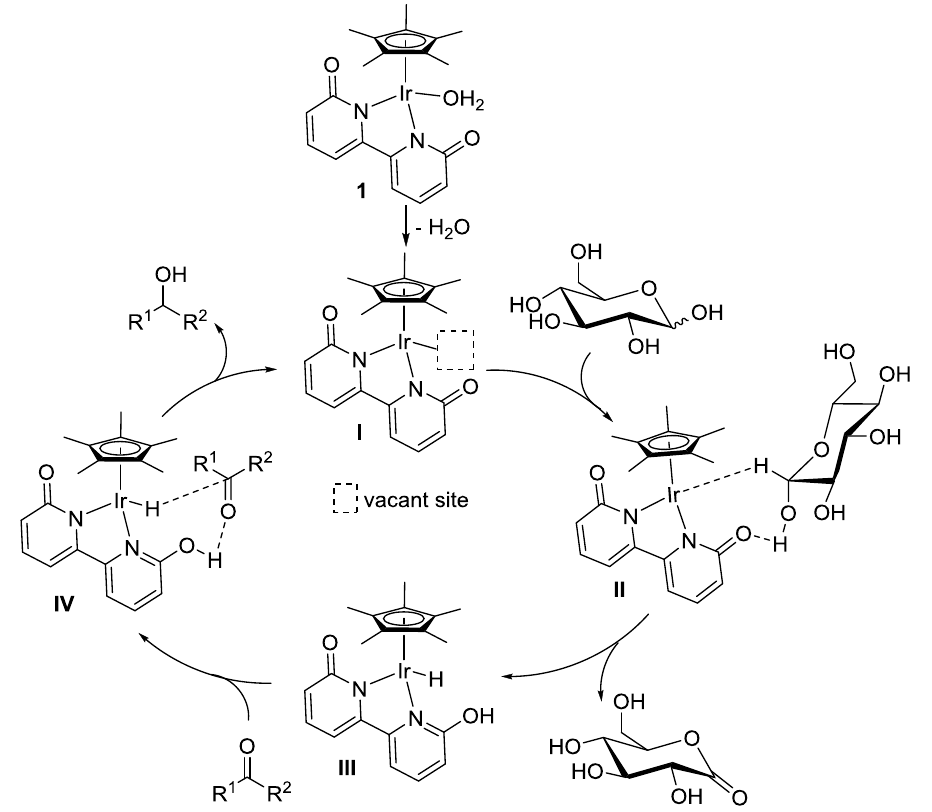
Figure 1. Additional experiments to determine which part of glucose functioned as a hydrogen donor.